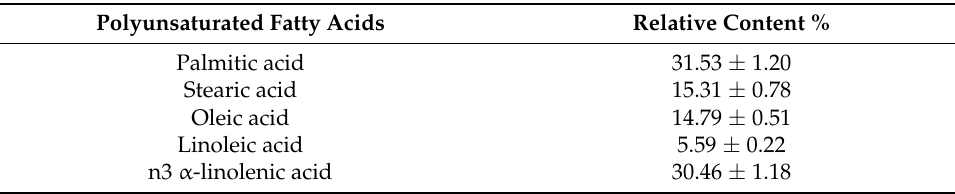
Table 1. The composition of SPO. Polyunsaturated Fatty